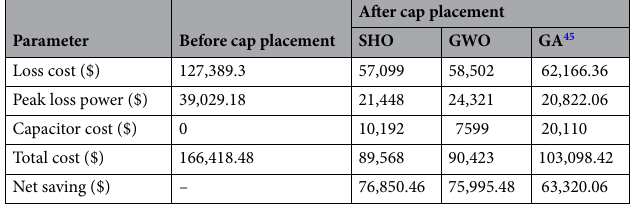
Table 11. Different amounts of cost in the network before and after the capacitor placement in the mode of cosφ#1.